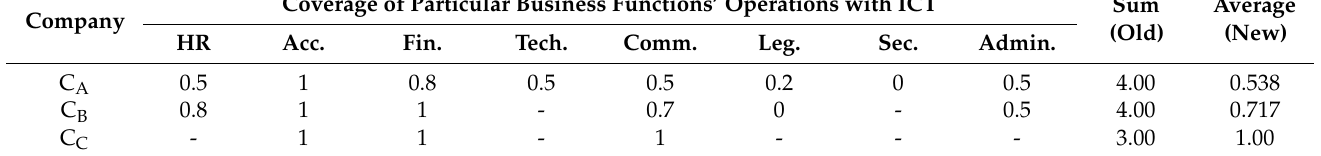
Table 1. Comparison between different approaches to calculate coverage of business operations by